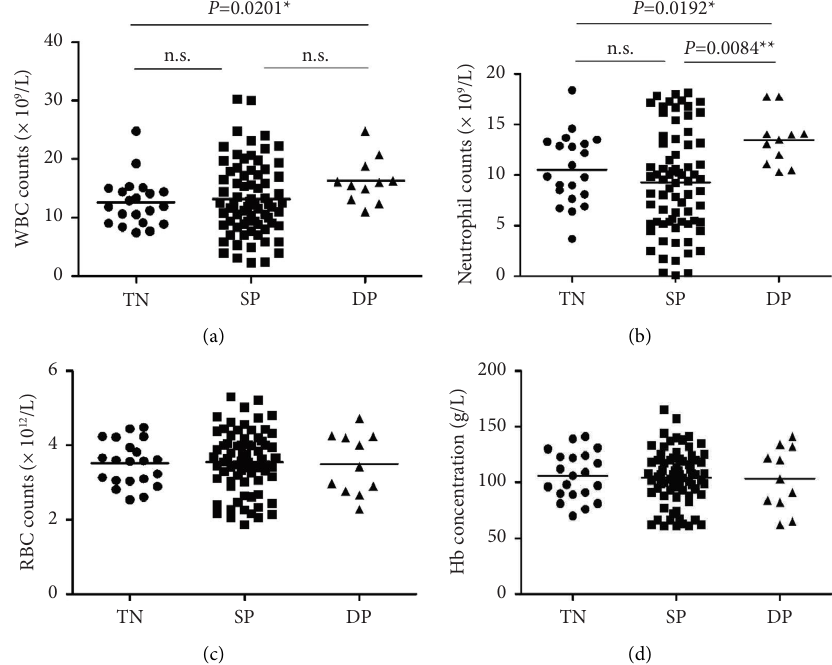
Figure 6: Comparison of peripheral blood cell counts in patients infected with S. aureus with diferent virulence factors.